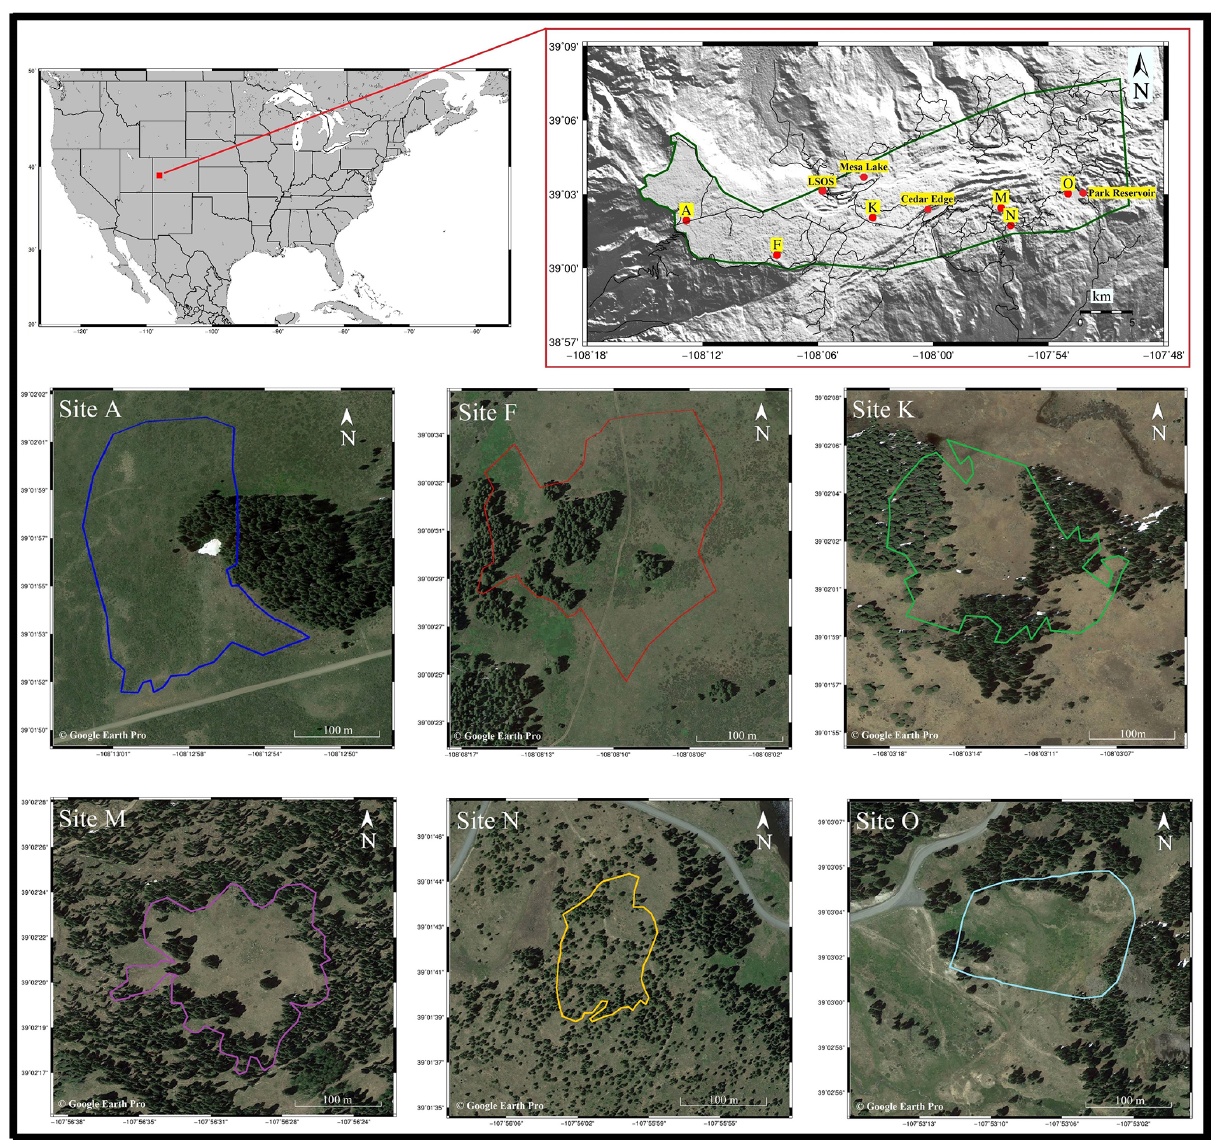
Figure 1. Study area and location of TLS sites and meteorological